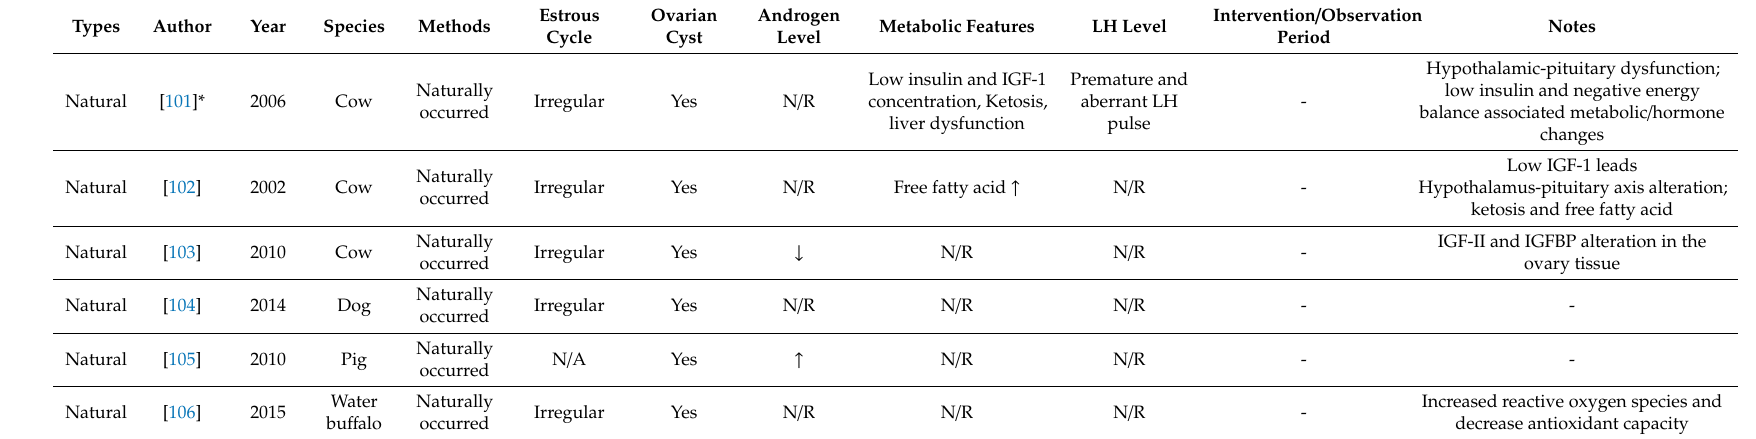
Table 3. Alterations of ovarian phenotype in the other